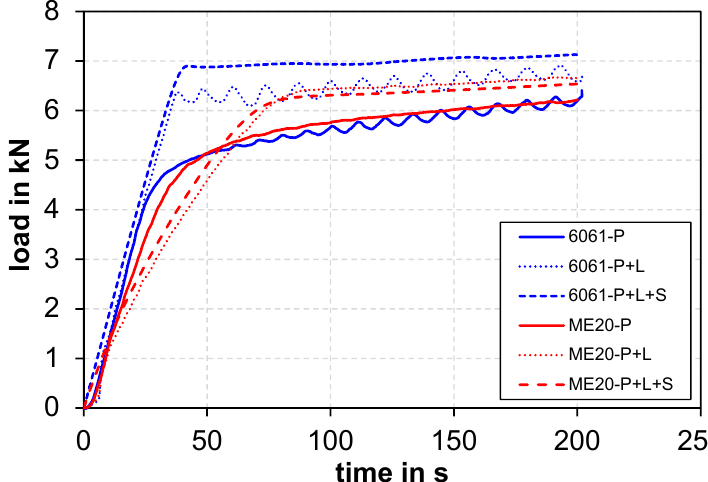
Figure 4. Load vs. time curves of AA6061 and ME20 alloys obtained after various combinations of auto-tuning.